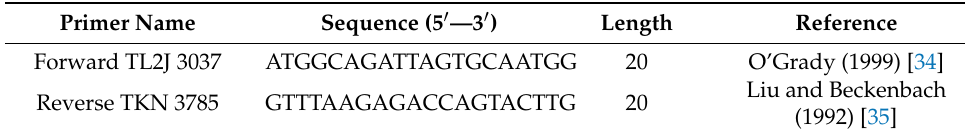
Table 2. Primer sequences used to amplify COII